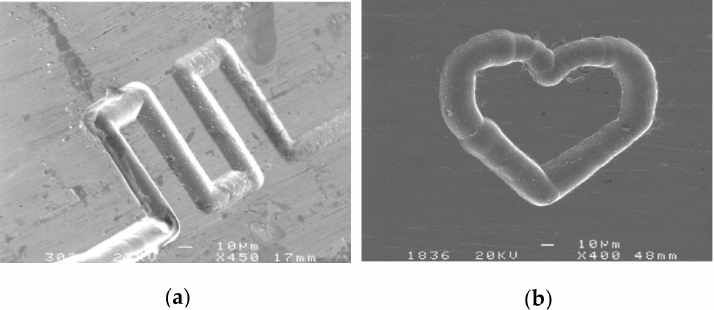
Figure 15. Two 2D complex micro-structures. ( a ) A micro-channel; ( b ) A heart-shaped